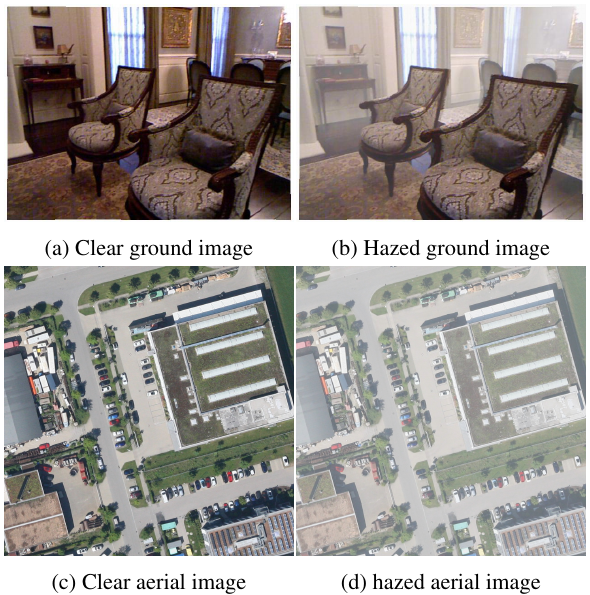
Figure 1: Sample ground image and aerial image with homogeneous hazy